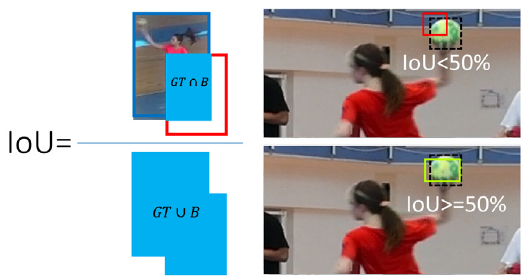
Figure 11. Visual representation of intersection over union (IoU) criteria equal to or greater than 50%.